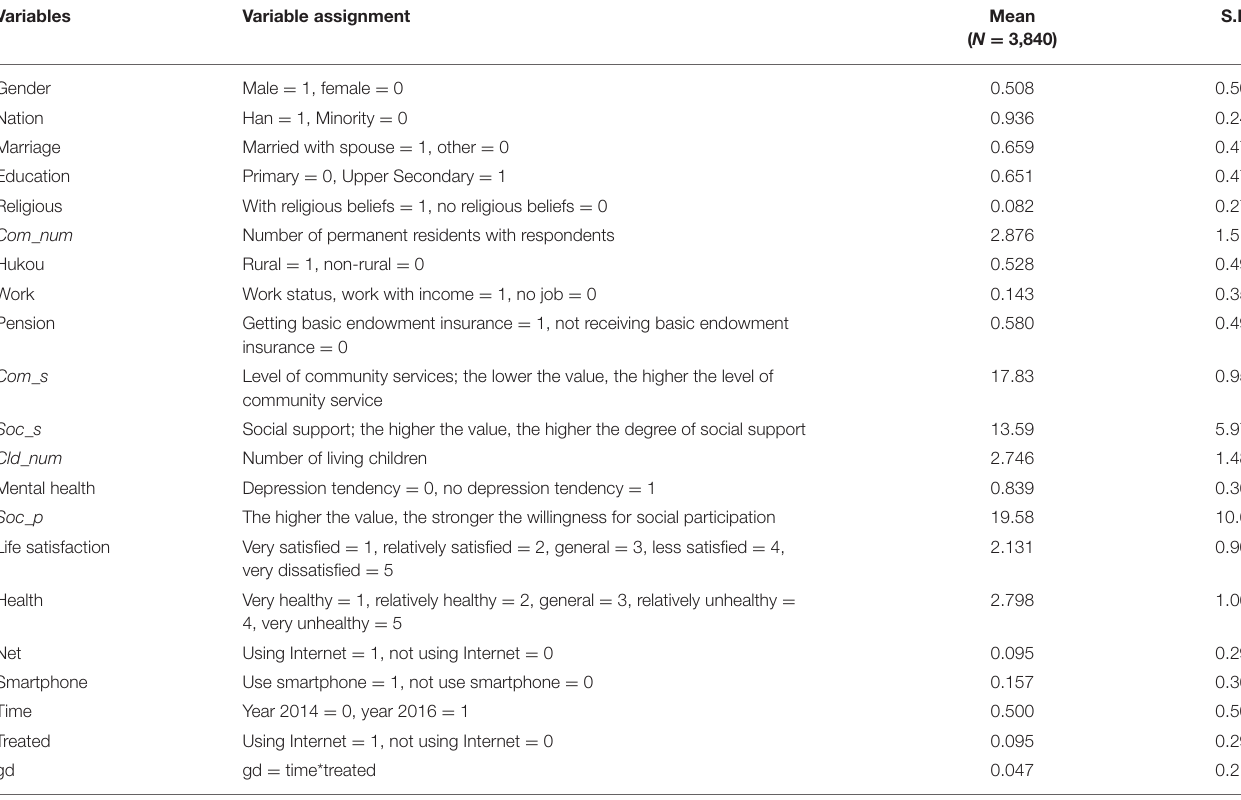
TABLE 6 | Descriptive statistics of variables using the DID method.